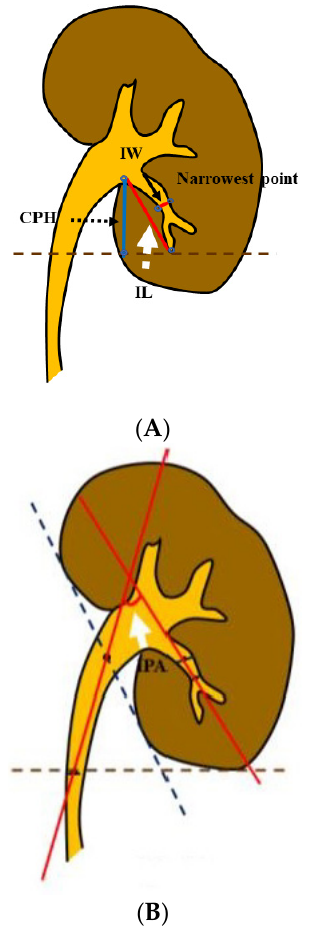
Figure 1. Spatial anatomical measurement of the renal collecting system. ( A ) The white dotted arrow indicates the infundibular length (IL); the slender black arrow indicates the infundibular width (IW); and the black dotted arrow indicates the calyceal pelvic height (CPH). ( B ) The white arrow indicates the infundibulopelvic angle (IPA).